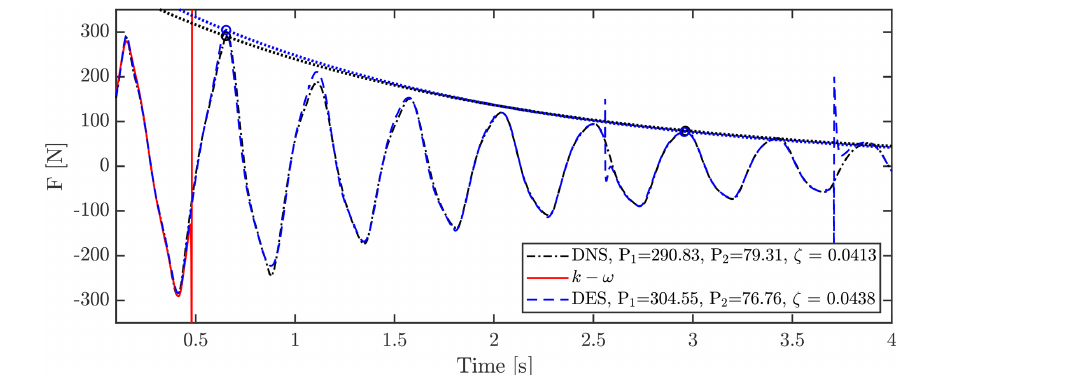
Figure A4. Sum of aerodynamic forces on the blade during vibration using no turbulence model (pseudo-DNS), k − ω SST and DES k − ω SST.